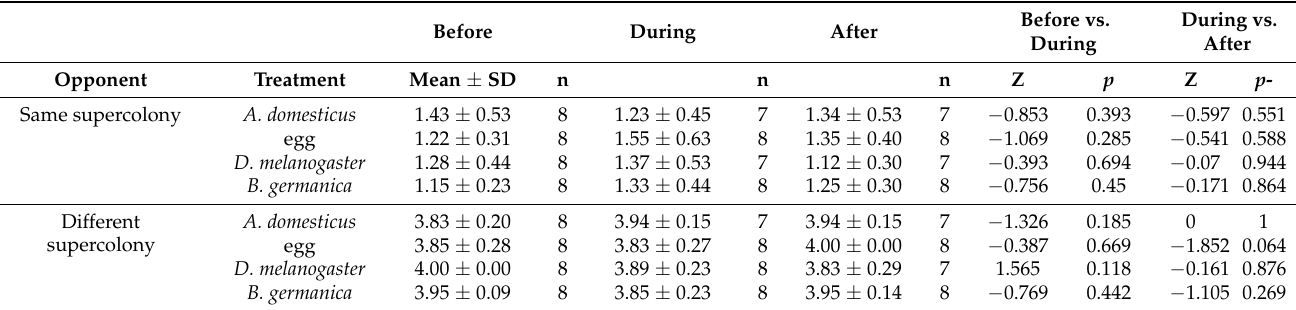
Table 1. Mean level of aggression ( ± SD), before, during and after the dietary experiments in the field. Z scores and p values are from Mann-Whitney U-tests. Before During After